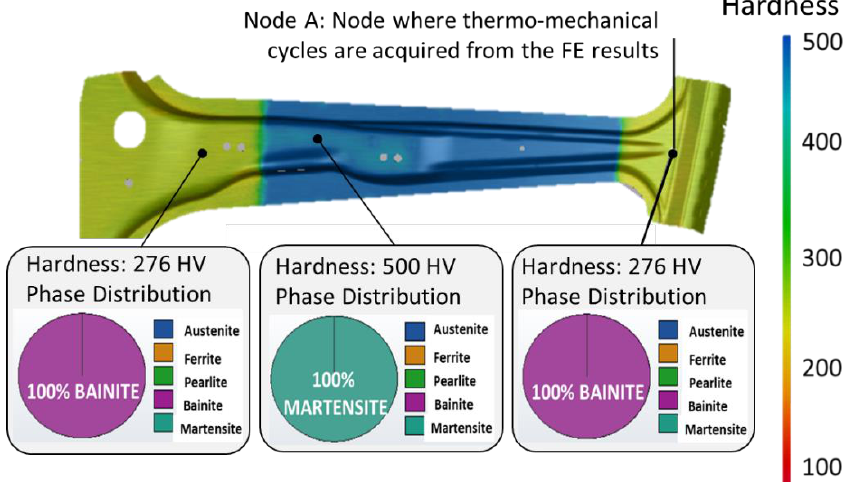
Figure 9. Distribution of the desired microstructure on the component at the end of the process (FE model with the USIBOR ® 1500 material for temperature of heated tools of 500 °C and quenching time of 50 s).